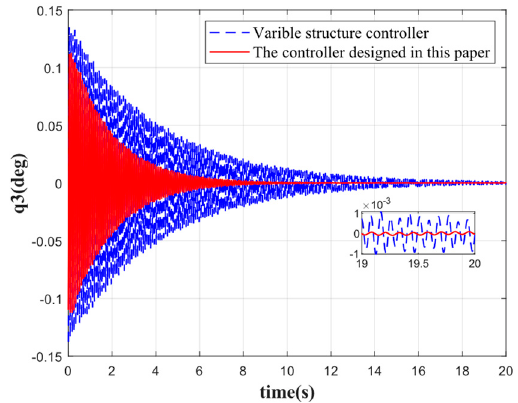
Figure 7. Third ‐ order elastic vibration mode without external interference.